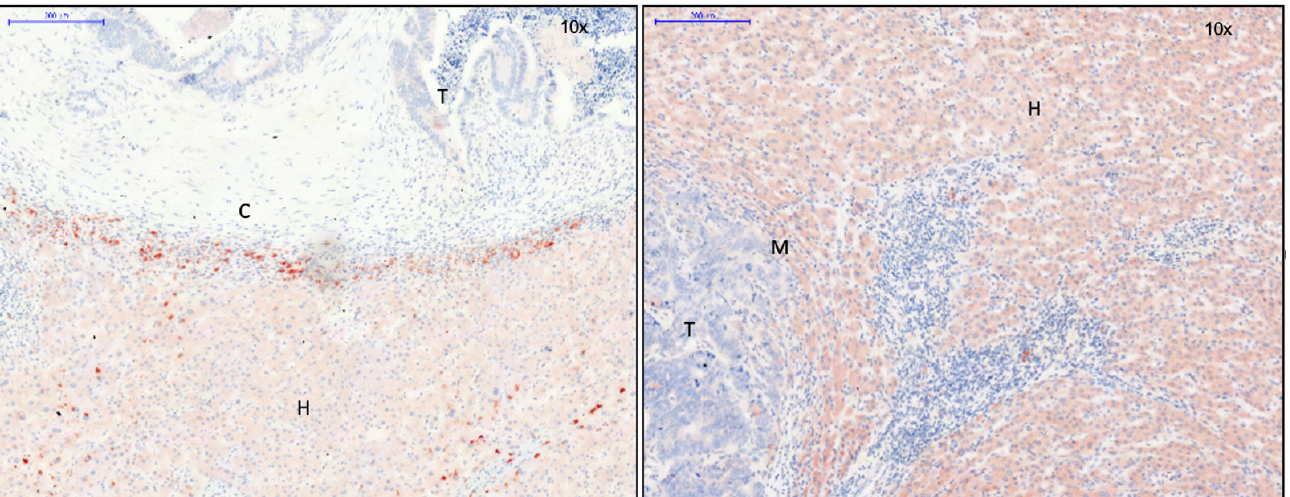
9 of 15 Figure 5. Left: capsule; right: no capsule. ( A ) E-cadherin immunohistochemistry, 10× magnification. Expression of E-cadherin is reduced at the tumor margin, especially in CRLM without capsule. ( B ) E-cadherin immunofluorescence, 20× magnification. Expression of E-cadherin is reduced at the tu- mor margin in CRLM without capsule. ( C ) Keratin-19 immunohistochemistry, 10× magnification. Intercellular expression of keratin-19 in the tumor area. In CRLM without capsule, expression is reduced at the tumor margin. ( D ) MAP1b immunohistochemistry, 20× magnification. Expression of MAP1b in cytoplasm of single liver cells surrounding the capsule (arrows). In CRLM, there was no evidence of MAP1b. Legend: T, tumor; H, hepatocytes; M, tumor margin; C, capsule. 3.2.5. Gene Products of Relevance for Extracellular Matrix The transcription of gene products relevant for collagen and matrix was upregulated